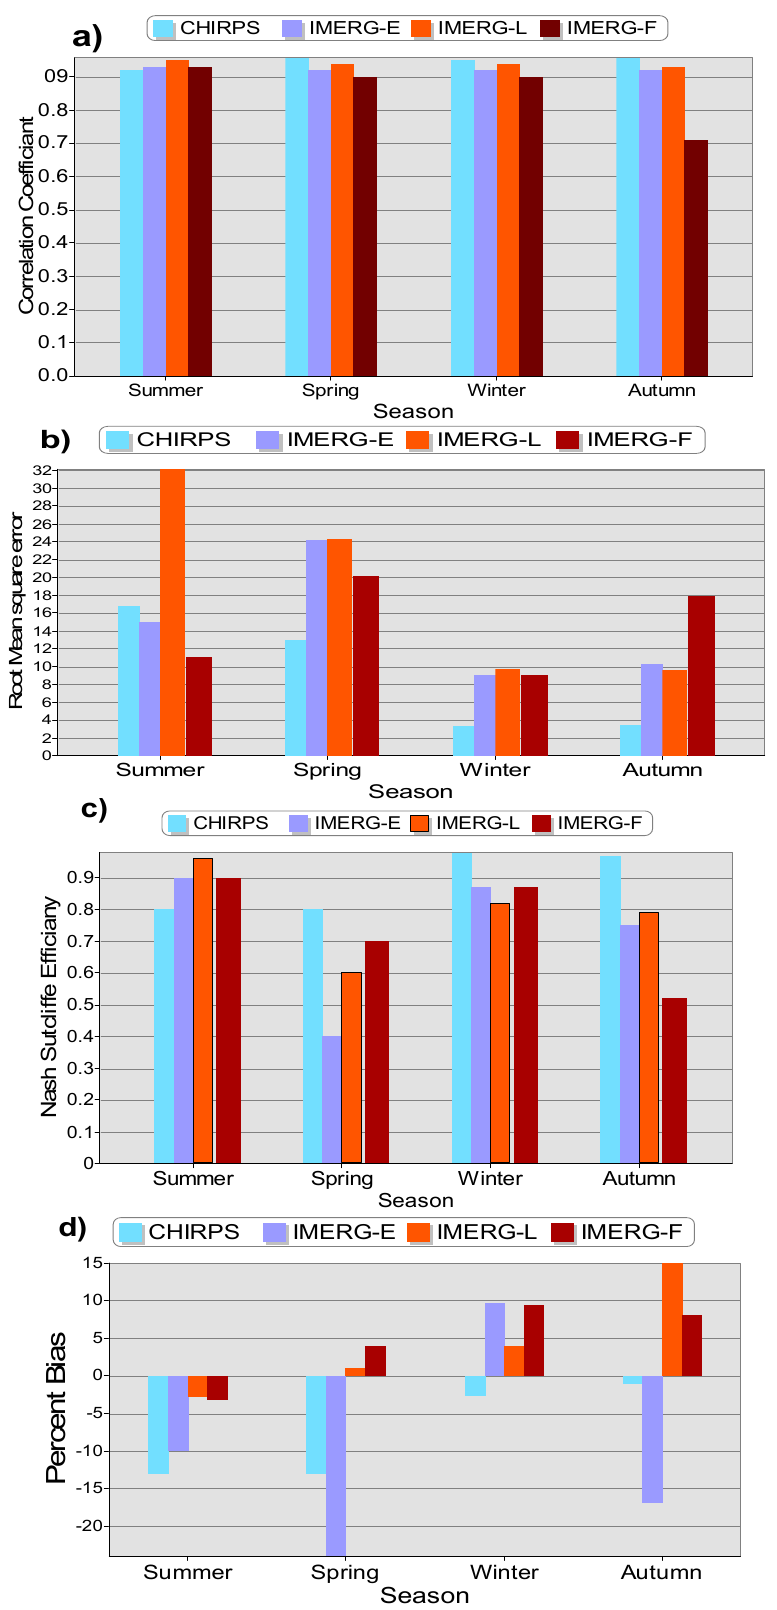
Figure 5. Seasonal performance evaluation indices of CHIRPS, IMERG-E, IMERG-L, and IMERG-F run: Correlation Coefficient ( a ), Root Mean Square Error ( b ), Nash–Sutcliffe Efficiency ( c ), and Percent Bias ( d ) for the period 2000–2014.